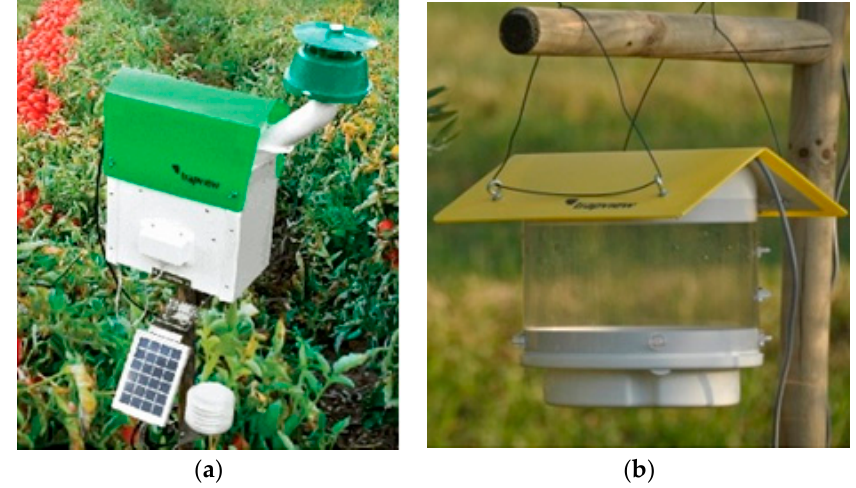
Figure 1. Automatic trap for monitoring and moth species ( a ) and fruit flies ( b ), EFOS, Trapview, Slovenia .